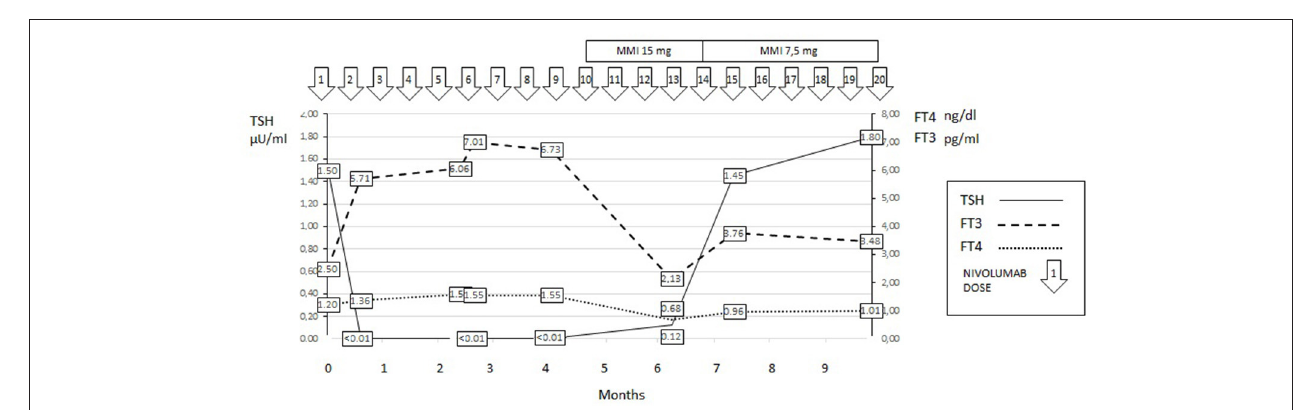
FIGURE 2 | Thyroid hormone profile of Case